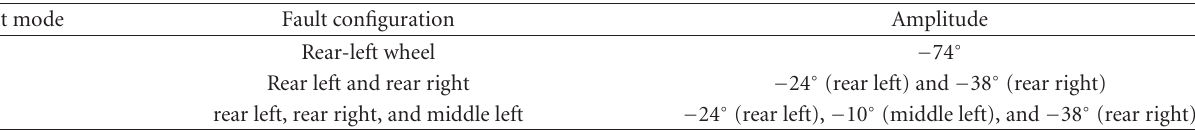
Table 2: Characteristics of injected fault modes.